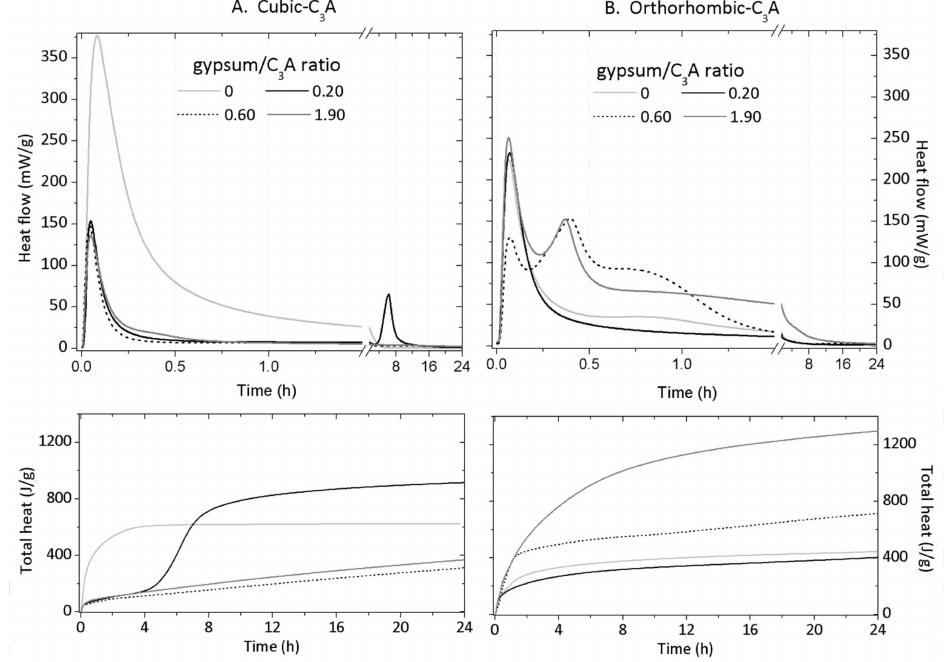
Figure 6. Rates of heat evolution ( top ) and cumulative heat ( bottom ) for ( A ) cub- and ( B ) orth-C 3 A hydration in the presence and absence of